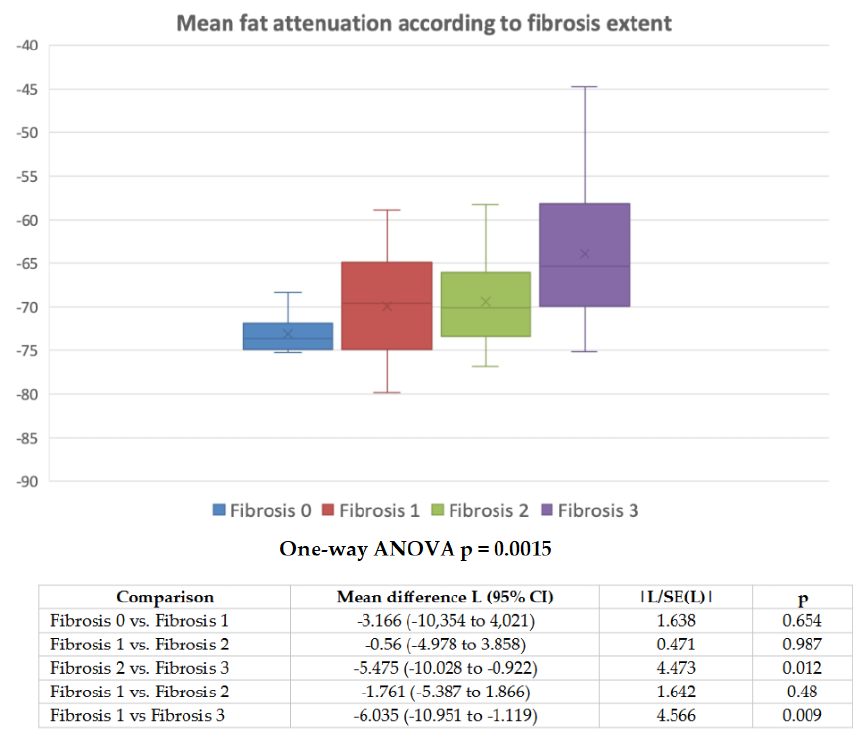
Figure 6. Mean fat attenuation in each group of patients divided based on fibrosis grade and p for significance of one-way analysis of variance (Welch adjusted ANOVA), with Tukey–Kramer multiple comparisons.